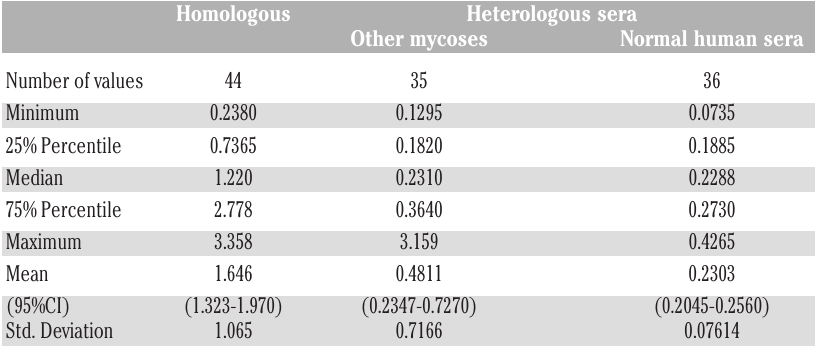
Table 4. Differences in statistical parameters and descriptive measurement of the ELISA for detection of antibodies against